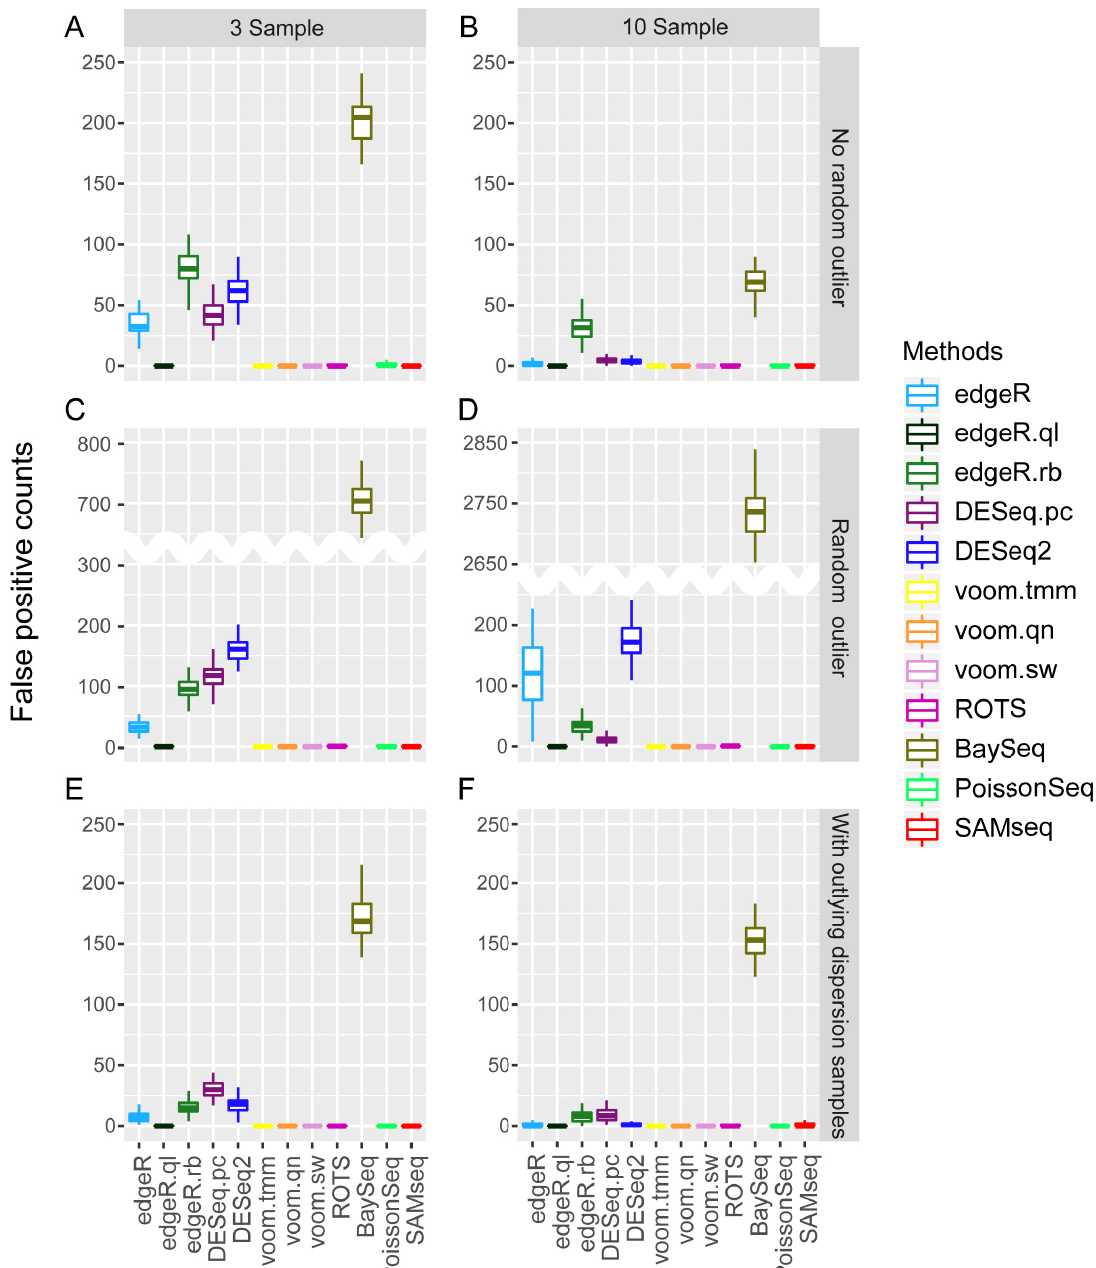
Fig 3. False positive count comparison of 12 DE analysis methods for simulated RNA-seq data with KIRC parameters. Three and ten samples in each sample group and three different conditions (No random outlier, random outlier, and outlying dispersion sample) were used for